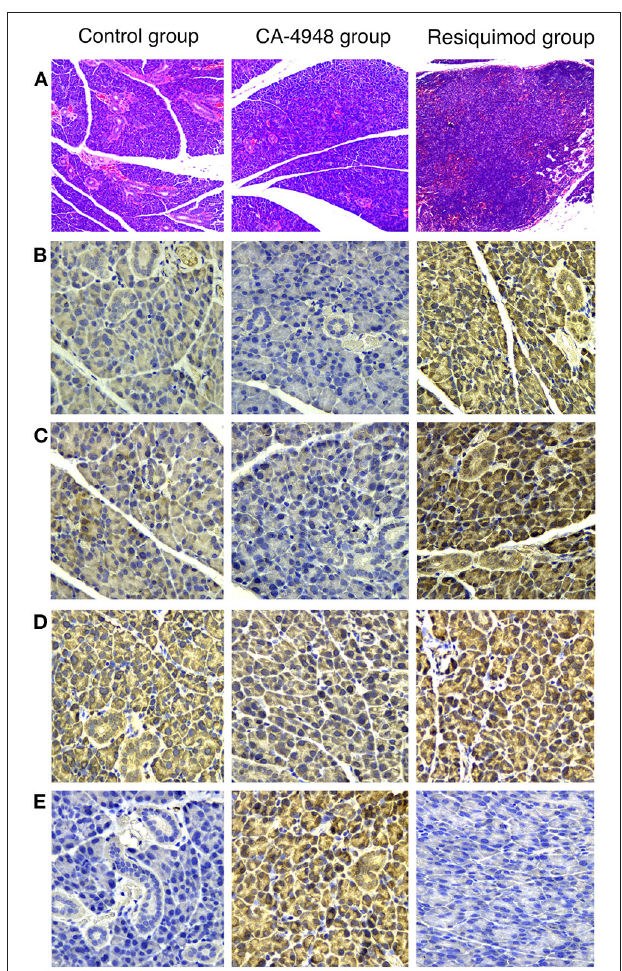
FIGURE 5 | Hematoxylin and eosin-stained sections and Immunohistochemical (IHC) stained sections of the submandibular gland tissue of NOD mice. Submandibular gland was obtained at the age of 13 weeks, 5 weeks after intervention of CA-4948/Resiquimod/saline. (A) Infiltration of scattered lymphocytes was present in interstitial tissue (original magnification × 100). (B) IHC of Interleukin (IL)-1 β (original magnification × 400). (C) IHC of IL-8 (original magnification × 400). (D) IHC of Megakaryocyte Colony Stimulating Factor (MK-CSF) (original magnification × 400). (E) IHC of thrombopoietin (TPO) (original magnification × 400). Expression levels of IL-1 β , IL-8, and MK-CSF were stronger in the Resiquimod-treated group than in the saline control. However, decreased expression of IL-1 β , IL-8, and MK-CSF and increased expression of TPO in the CA-4948 group were observed compared to that in the control